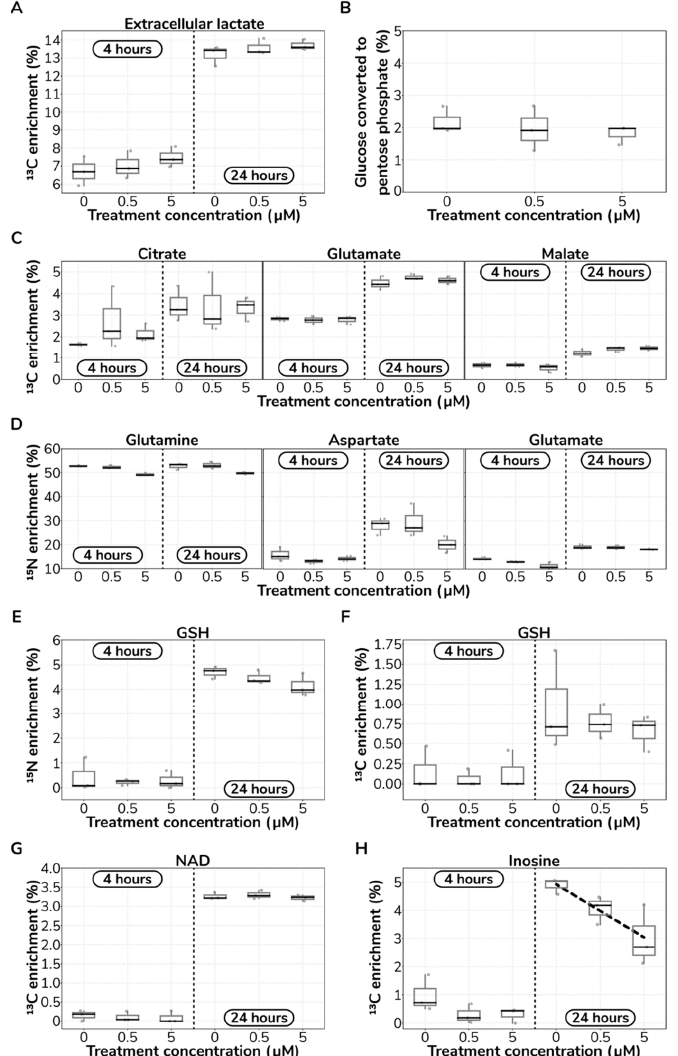
Figure 5. Catecholamine stimulation does not rewire central carbon and nitrogen metabolism. ( A ) Measured mean isotopic 13 C enrichment in extracellular lactate derived from glucose-1,2- 13 C 2 . ( B ) Measured ratio of glucose converted into pentose phosphate. ( C ) Measured mean isotopic 13 C enrichment in TCA cycle metabolites derived from glucose-1,2- 13 C 2 . ( D ) Measured mean isotopic 15 N enrichment in selected metabolites derived from glutamine- 15 N 2 . ( E ) Measured mean isotopic 15 N enrichment in glutathione derived from glutamine- 15 N 2 . ( F ) Measured mean isotopic 13 C enrich- ment in glutathione derived from glucose-1,2- 13 C 2 . ( G ) Measured mean isotopic 13 C enrichment in selected metabolites derived from glucose-1,2- 13 C 2 . ( H ) Measured mean isotopic 13 C enrichment in selected metabolites derived from glucose-1,2- 13 C 2 . The dashed line indicates the negative relation- ship between mean isotopic enrichment in inosine and catecholamine concentration ( r = − 0.801; p < 0.01).